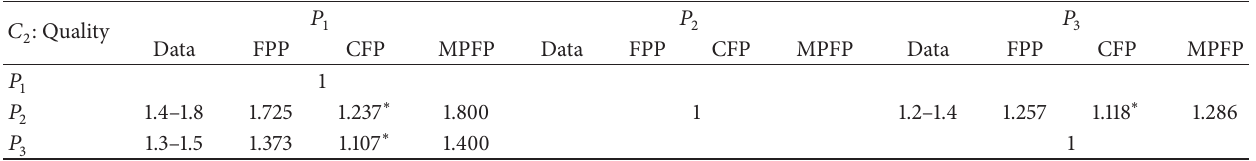
Table 6: Solution matrix of alternatives for 𝐶 2 (Example